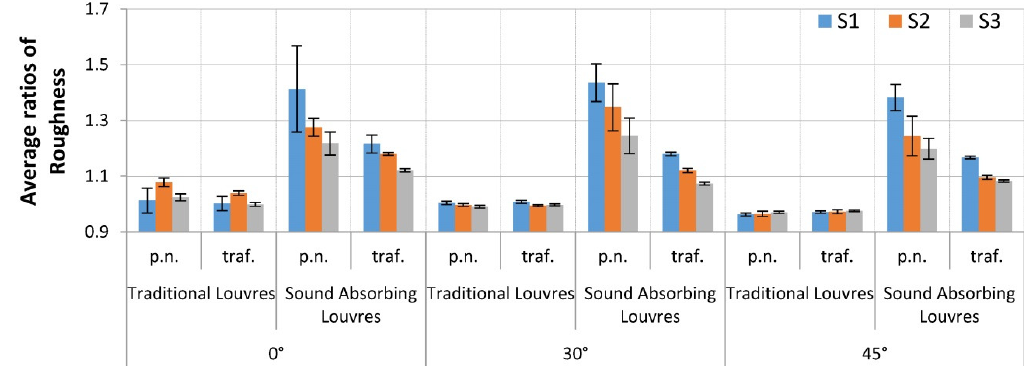
Figure 8. Average ratios of Roughness due to the presence of the traditional louvres compared to the sound absorbing louvres. The bars in the figure are listed according to the source positions used for the measurements (S1, S2, and S3). Error bars report the doubled standard deviations for each average. The acronym “p.n.” refers to the pink noise signal. The abbreviation “traf.” refers to the standard traffic noise.